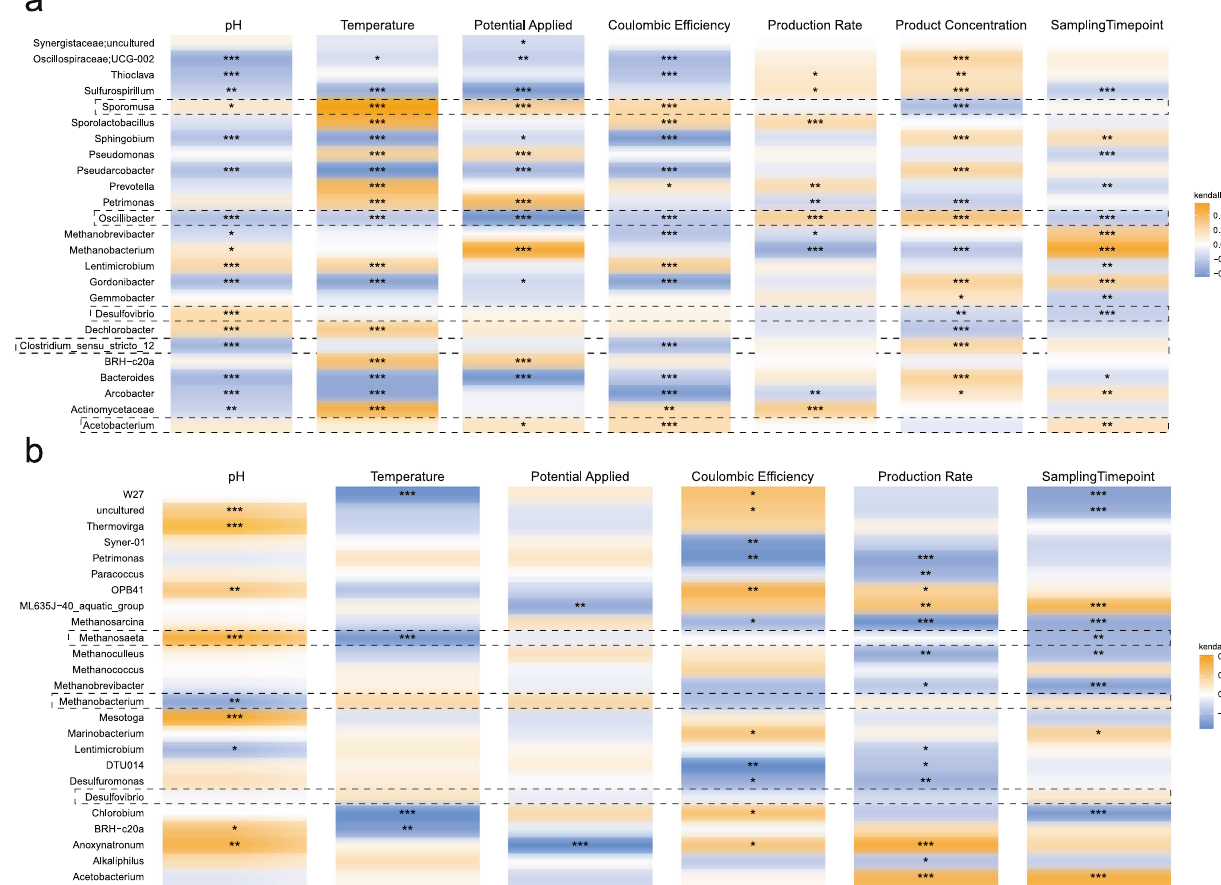
Fig. 4 Correlation between taxa and environmental parameters. Correlation heatmap of the 25 most abundant genera from ( a ) acetogenic, and ( b ) methanogenic cells with environmental variables. Kendall correlations between the taxa and the environmental variables were calculated. Signi fi cance levels are indicated by asterisks as *( p < 0.05), **( p < 0.01) or ***( p <